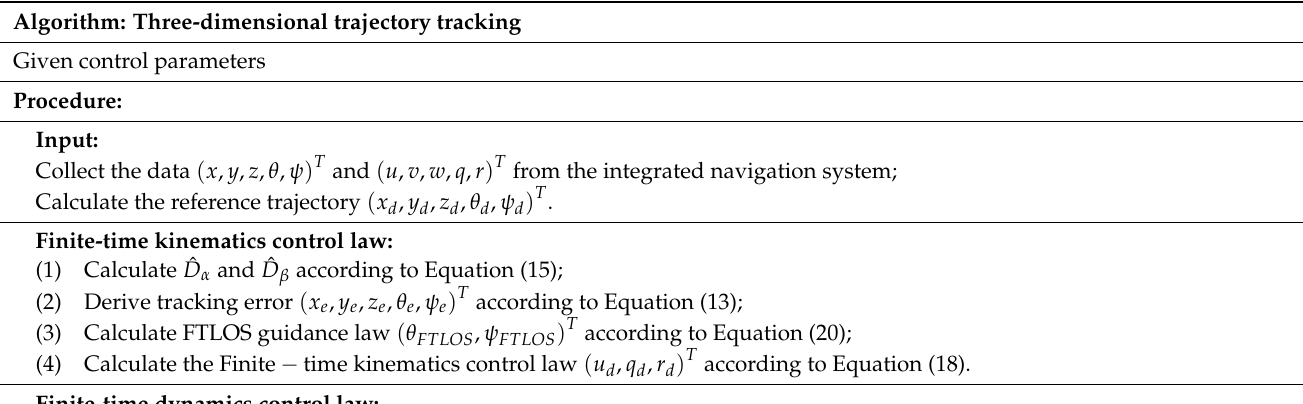
Table 3. Implementation of three-dimensional tracking control algorithm.